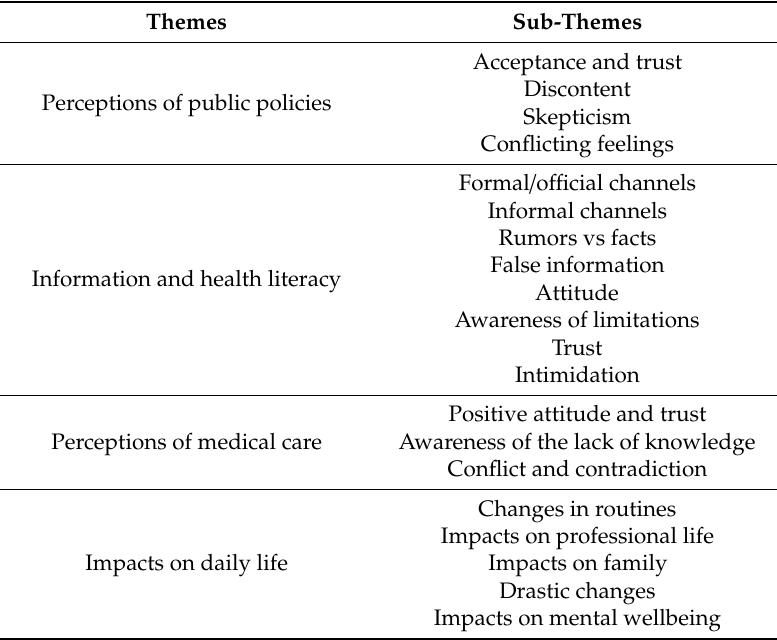
Table 2. Summary of themes and